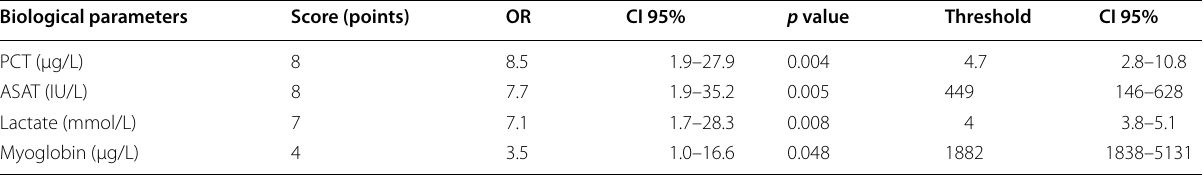
Table 3 Scoring system for the diagnosis of acute bowel ischemia Biological parameters